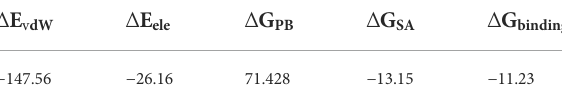
All the energy are in kJ/mol. Snapshots extracted from the last 0.5 ns MD simulation were submitted to MMPBSA.py for the free energy calculation. Δ E vdW , van der Waals